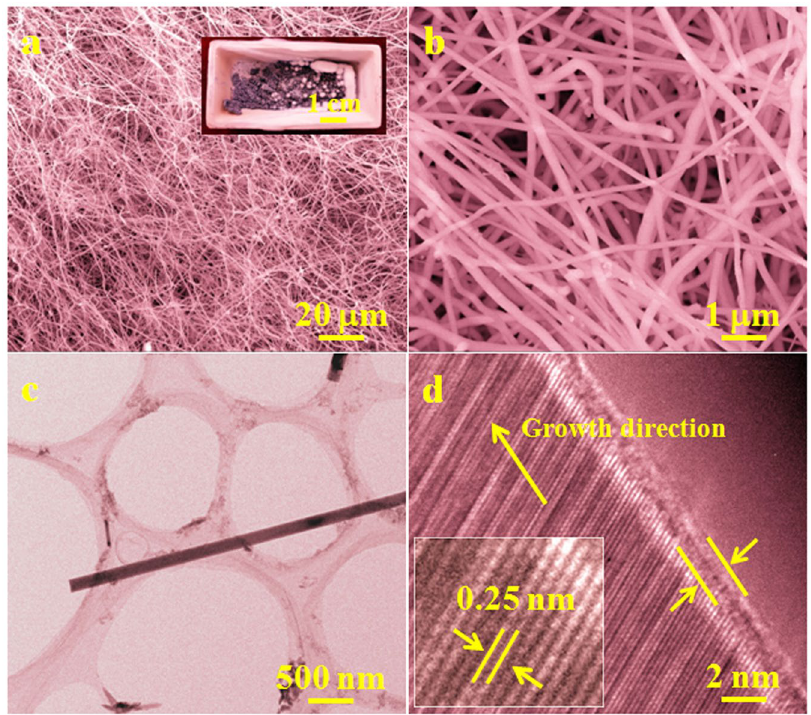
Figure 2. ( a , b ) SEM and ( c , d ) TEM images of the white, wool-like, products obtained from the inner wall of the ceramic crucible. The inset image in ( d ) shows the partial enlarged image of ( d ).